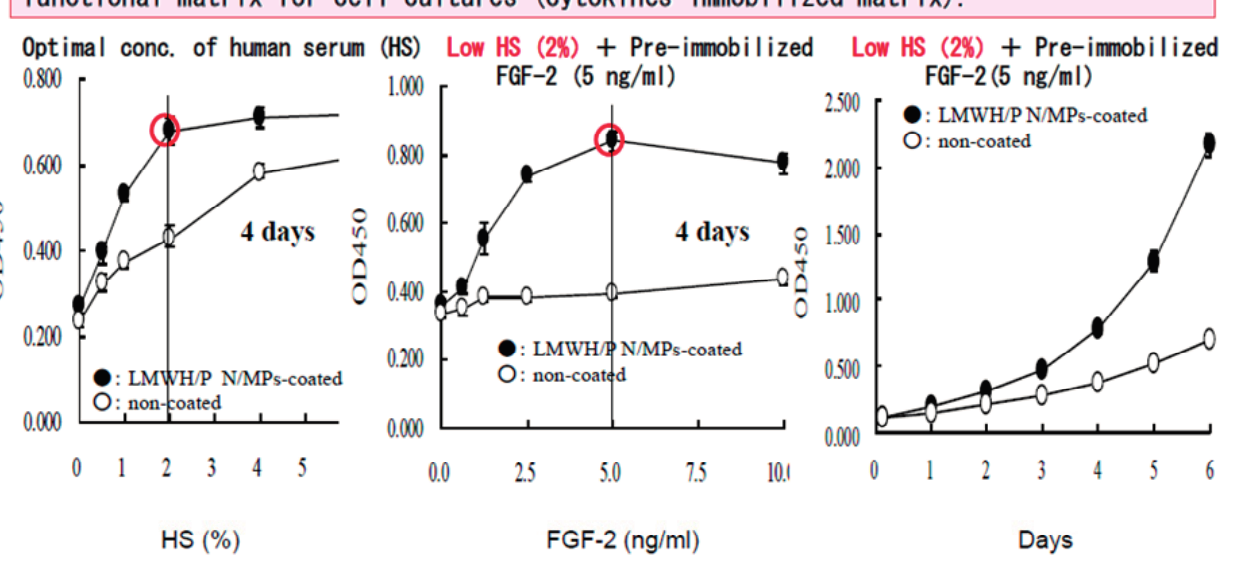
Figure 6. Expansion of adipose-derived stromal cells (ADSCs) with LMWH/P NPs-coated plates and human serum (HS). ADSCs effectively expanded with low HS (2%) and FGF-2 (5 ng/mL) instead of high FBS (10%) on LMWH/P N/MP-coated